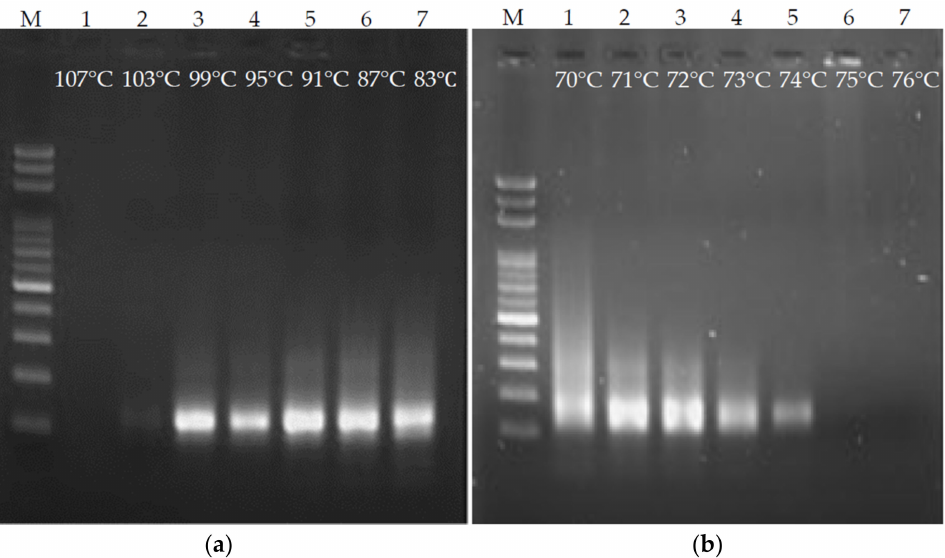
Figure 4. Temperature optimization of denaturation and annealing/extension of ultrafast PCR. The suitable temperature for ( a ) denaturation is between 99 ◦ C and 83 ◦ C and ( b ) annealing/extension is approximately 73 ◦